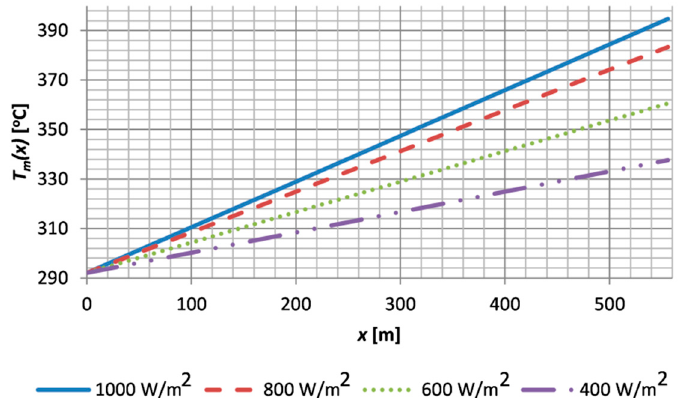
Figure 9. Temperature distribution of the medium flowing through the absorber as a function of the absorber length for different DNI.